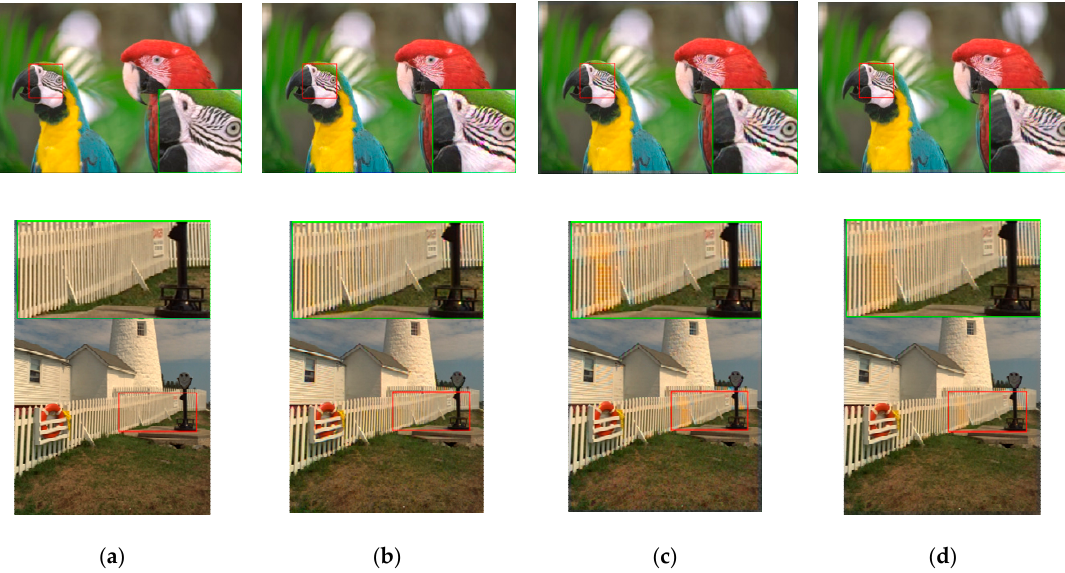
Figure 7. Visual comparison of three high performing demosaicing algorithms. The top row is the bird image and the bottom row is the lighthouse image. ( a ) Ground Truth; ( b ) Demonet + GSA; ( c ) ATMF; ( d ) F3.